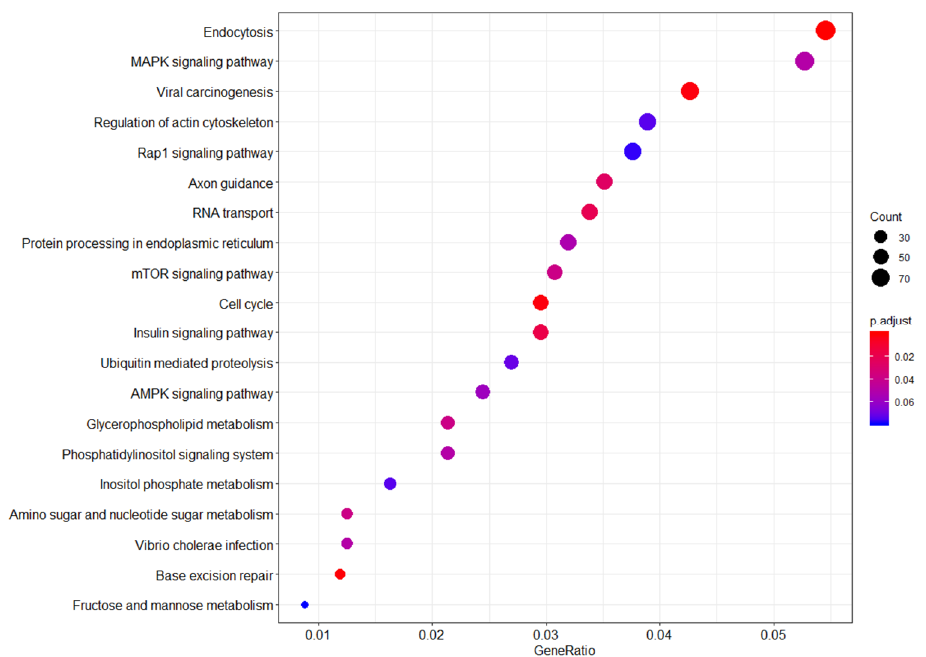
Figure 3. Functional genomic pathways enriched in the WTC-exposed (WTC EHC) cancer-free subjects compared to the unexposed cancer-free subjects (NYUWHS). Summary of pathway network analysis highlights the relationship between probe sets enriched in the WTC-exposed women compared to unexposed women. Y -axis shows the probe sets with significant overlap with the reference probe sets / genes from the KEGG database. X -axis shows the ratio of the number of di ff erentially expressed probe sets / genes to the total number of genes included in the particular pathway gene set from the reference KEGG pathway database. The dot sizes are proportional to the number of overlapping probe sets / genes. The dot colors show the p-value adjusted for false discovery